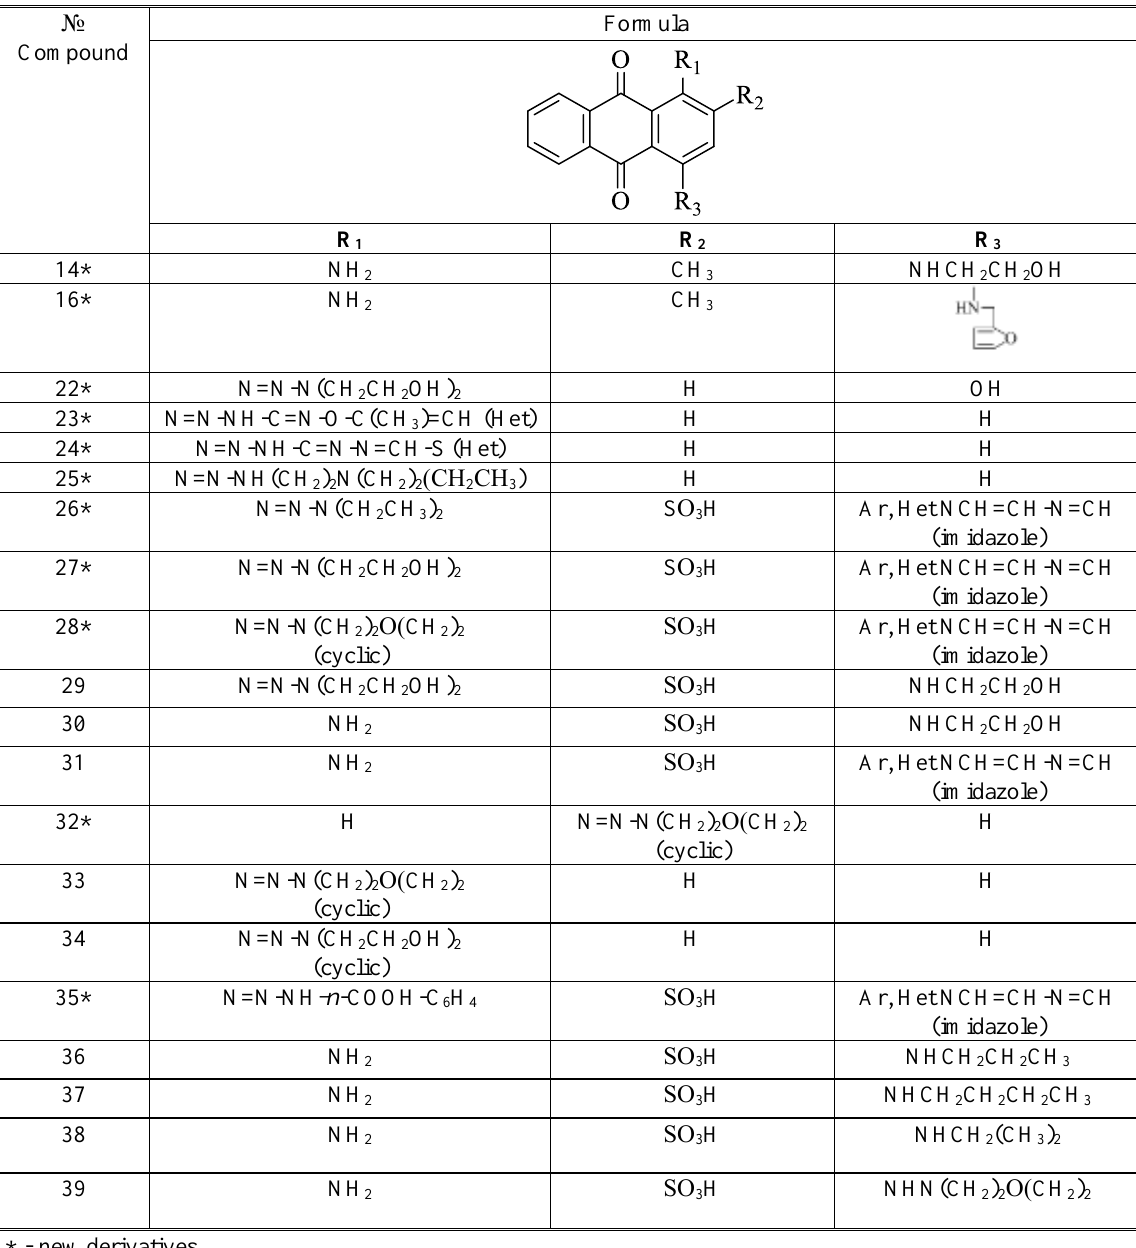
Table 1. Synthesized compounds for antimicrobial studies № Compound